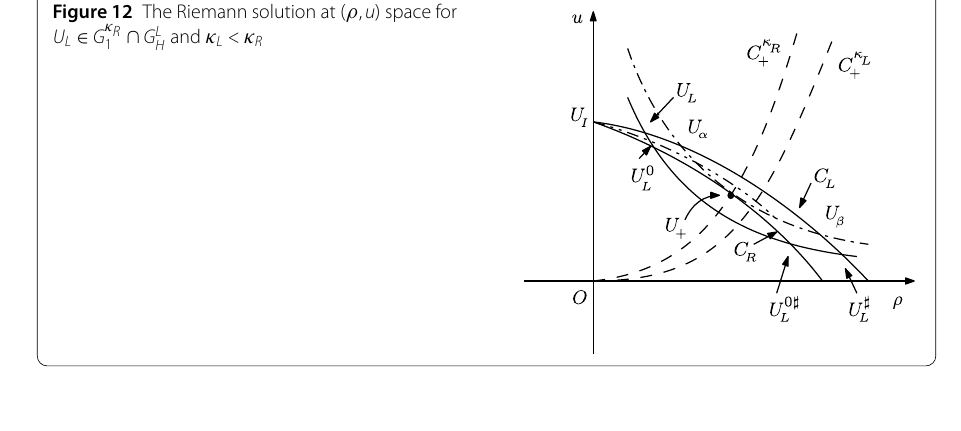
Figure 13 The Riemann solution at ( ρ , u ) space for